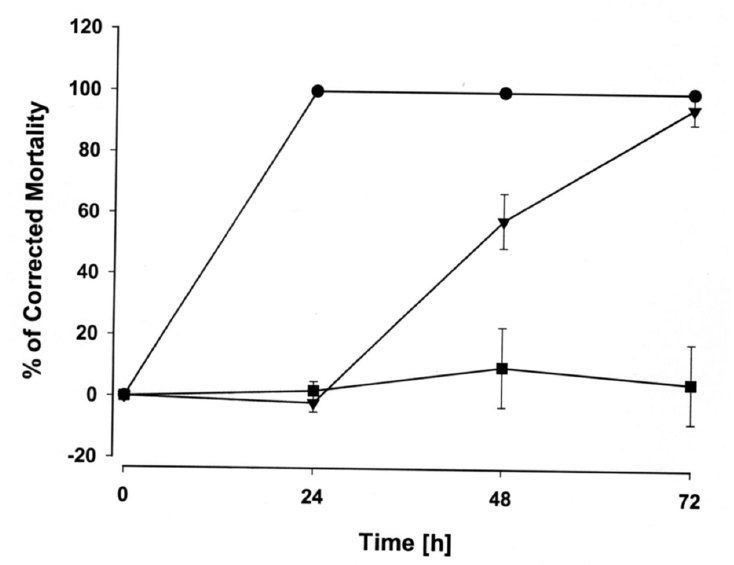
FIGURE 1. Percentages of corrected mortality at three different exposure concentrations for LAS homologue C 14 vs. exposure time. ( ● = 0.2 mg l -1 ; ▲ = 0.1 mg l -1 ; ■ = 0.07 mg l -1 ).